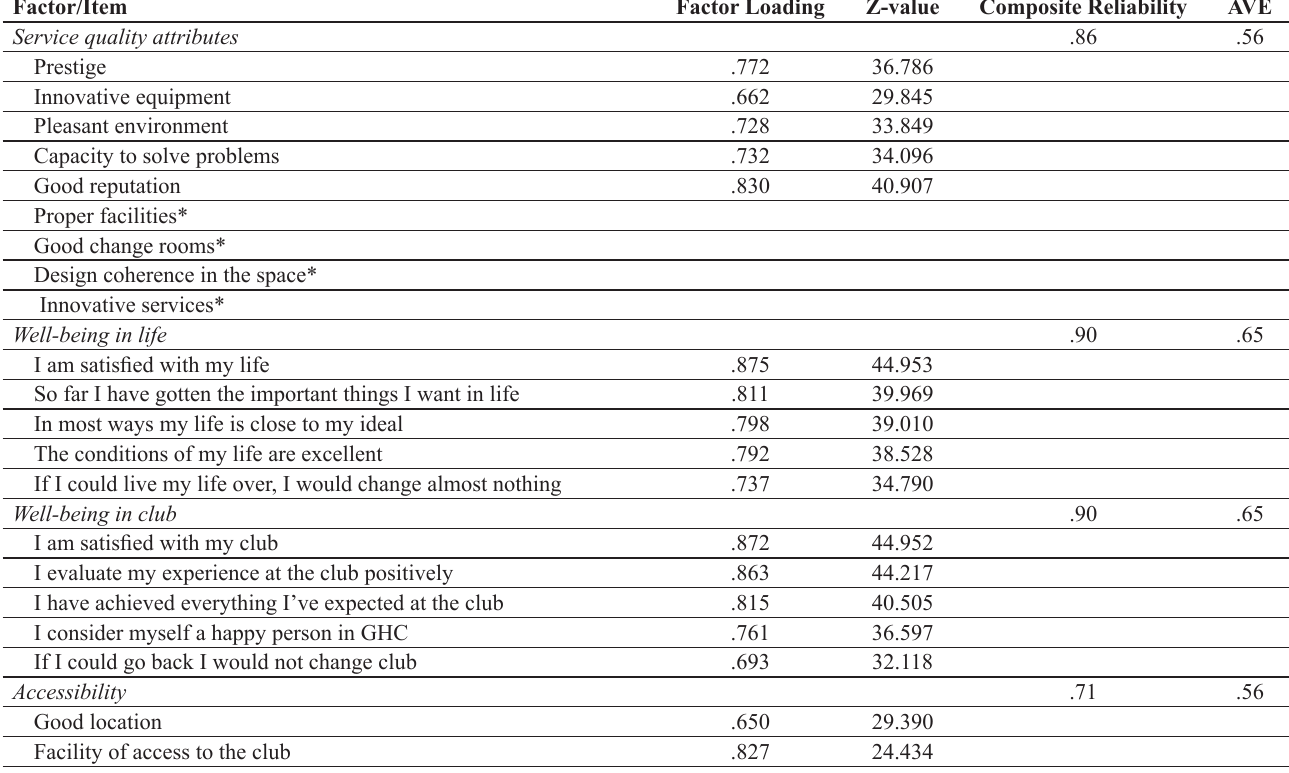
Table 3. Mean (M), standard deviation (SD) and correlations among the constructs.